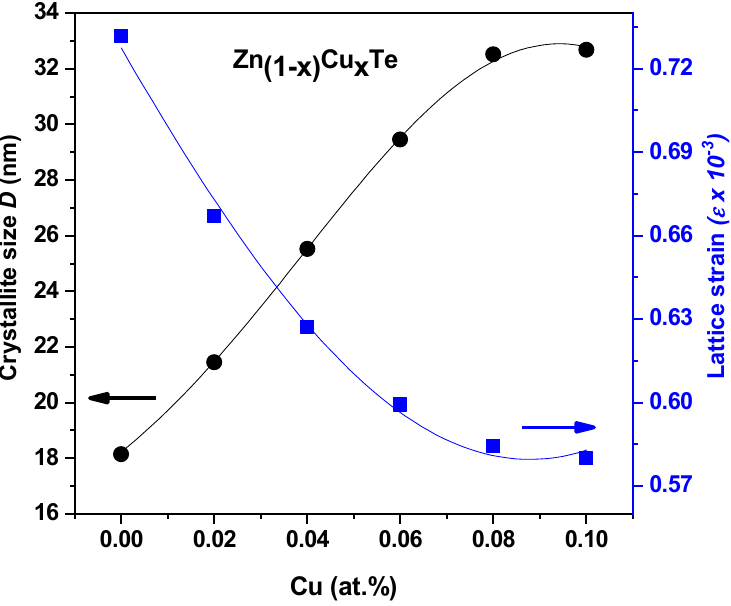
Figure 4. Crystallite size and lattice strain of the ZnTe:Cu thin films. Table 2. Crystallographic parameters of ZnTe and the ZnTe:Cu thin films.